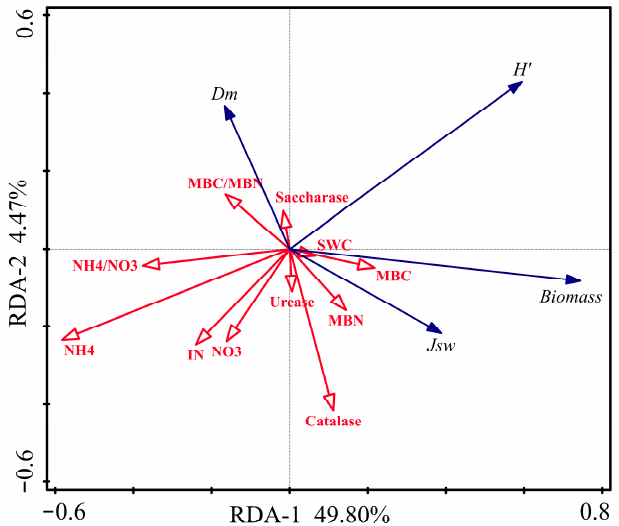
Figure 9. RDA between the understory vegetation characteristics (blue arrows) and soil properties (red arrows) under different pruning treatments. Note: the results of RDA are used to identify the rela- tionships between the understory vegetation characteristics and soil properties; n (27) = three pruning treatments × nine replications. The percentages on the x -axis and y -axis reflect the response rate of the soil properties to the changes in understory vegetation characteristics in different dimensions.